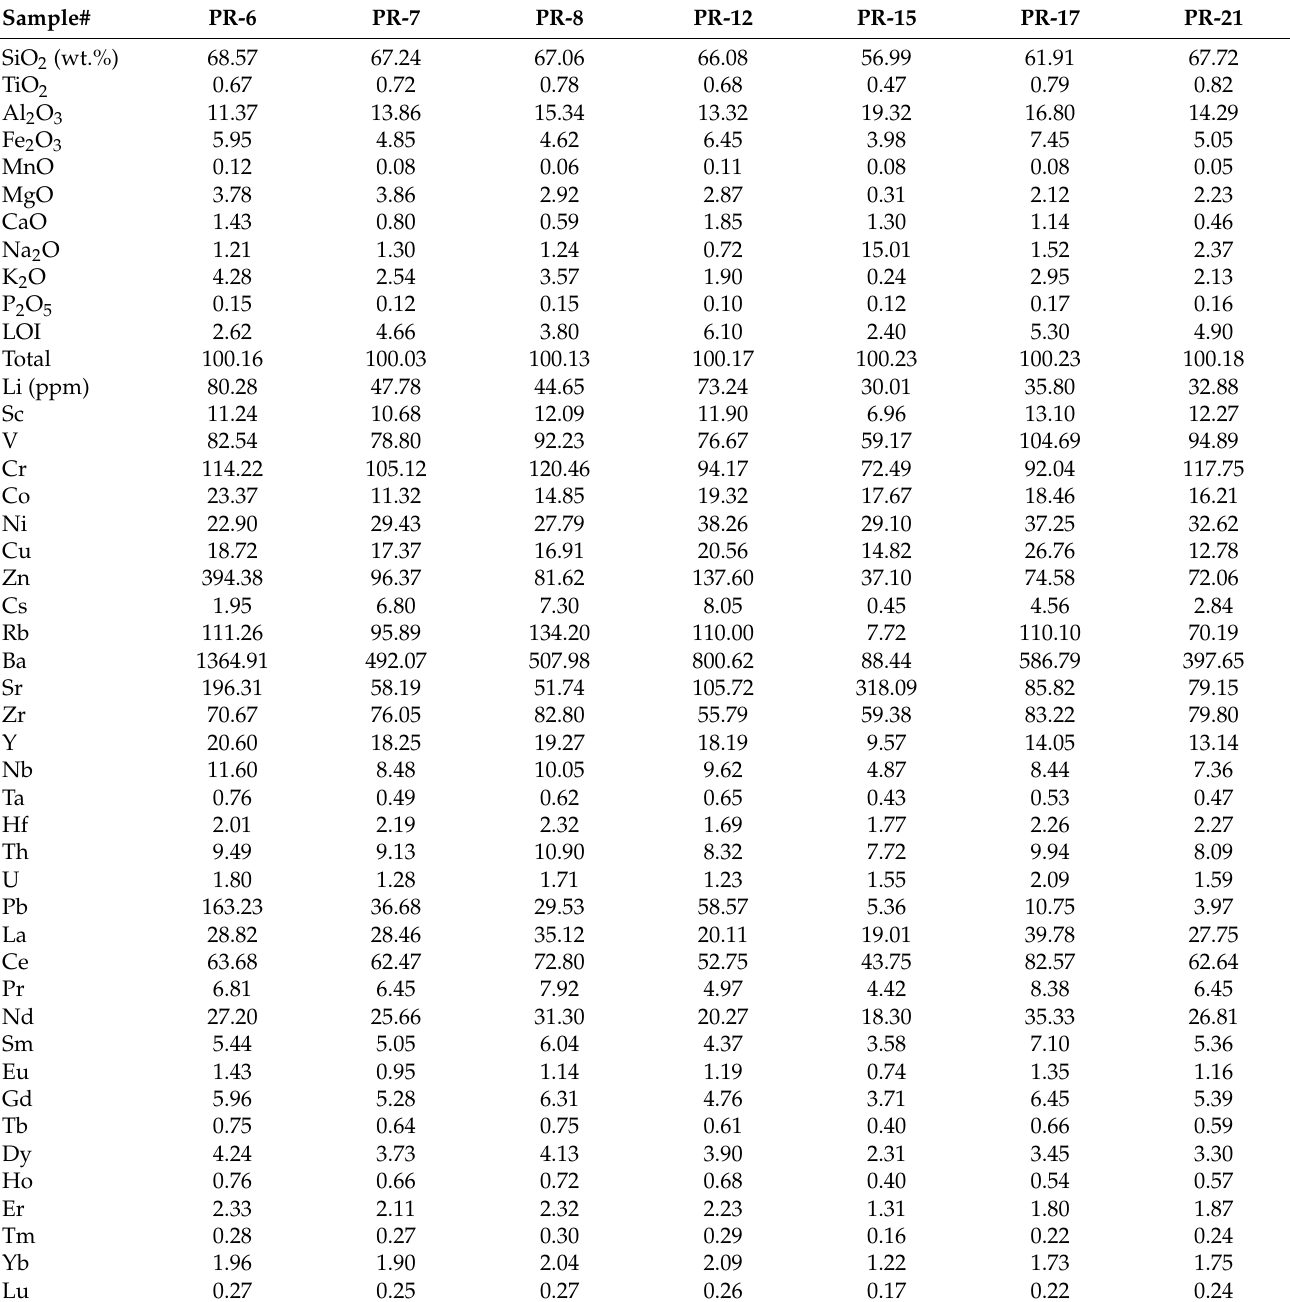
(Figure 8). REE compositions are also characterized by weak negative Eu and Tm anomalies (Figure 8). Table 4. Chemical composition of Paleozoic tuffs from the Priorat DOQ region